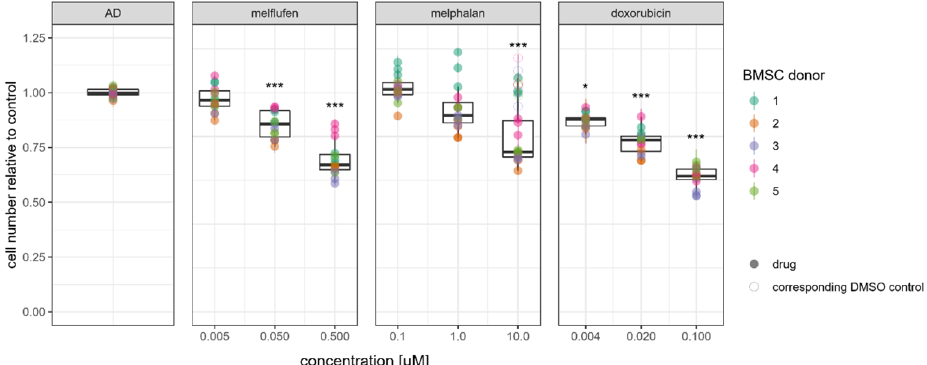
Figure 4. Drug effect on BMSC proliferation in adipogenic differentiation conditions. Relative numbers of BMSCs at 21 days of culture in adipogenic differentiation conditions with melflufen, melphalan, and doxorubicin added at indicated concentrations. Dots represent individual culture wells with a color-coded donor cell line and crossbars indicating the measured range. Open circles indicate DMSO vehicle controls for 10 µ M melphalan. * denotes p < 0.05 and *** denotes p < 0.001 with Dunn’s